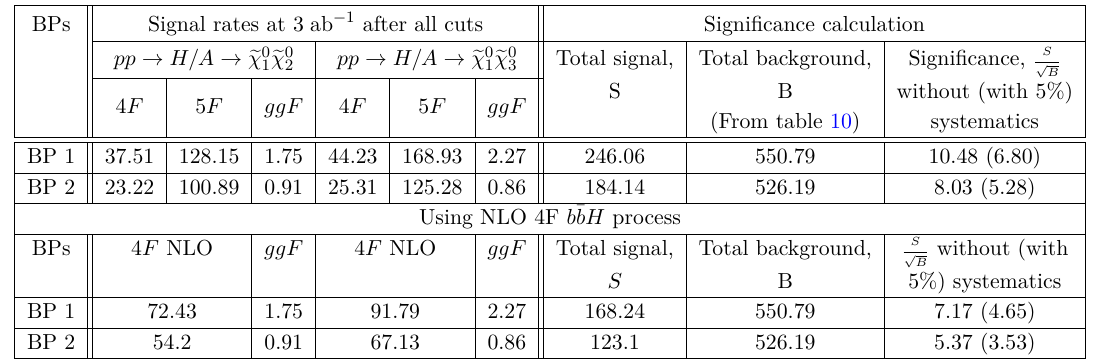
Table 11. The signal yield for two benchmark points along with signal significance for the b-tag category of ‘‘ + /E final T